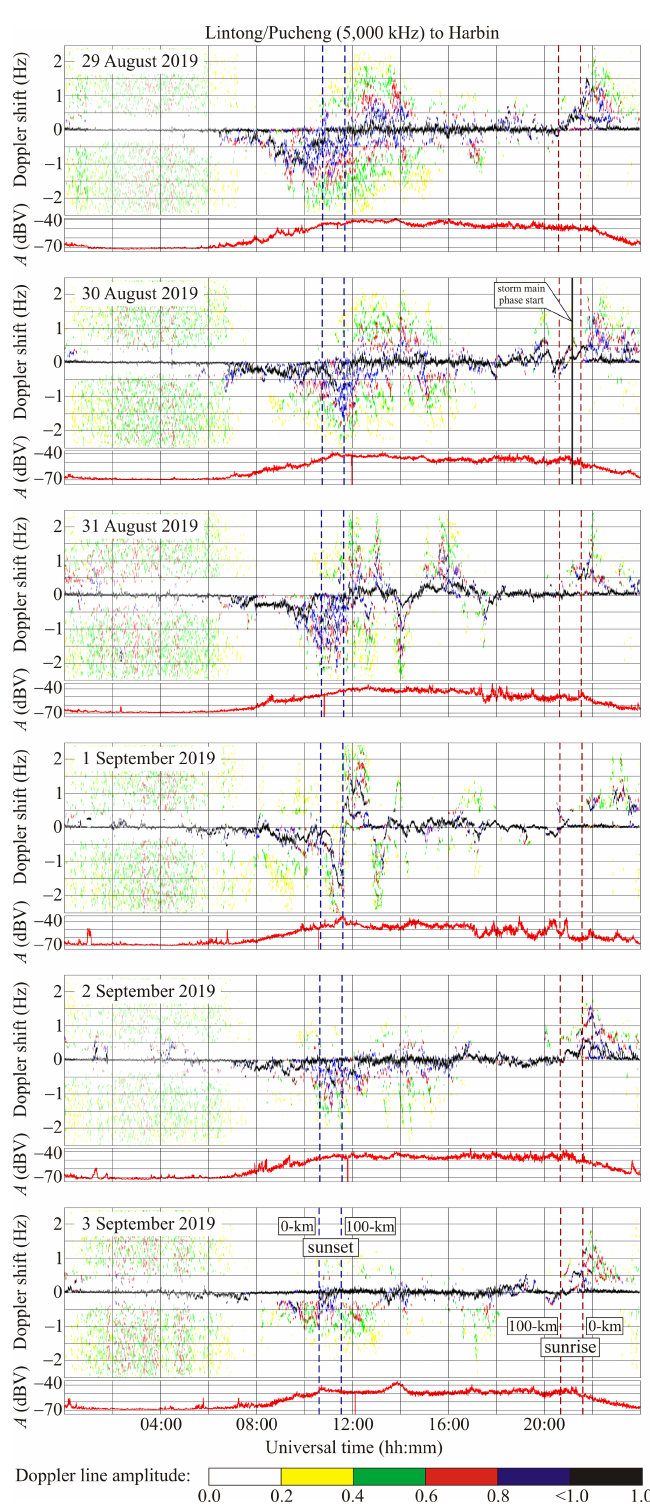
Figure 5. Universal time variations in Doppler spectra and relative signal amplitude, A , along the Lintong/Pucheng to Harbin propagation path for 30 and 31 August and 1 and 2 September 2019 (panels from top to bottom). The radio wave frequency is 5000kHz. The Doppler shift plot is comprised of 117600 samples at every 1h interval. The signal amplitude, A , at the receiver output in decibels, dBV, relative to 1V is shown below the Doppler spectrum in every